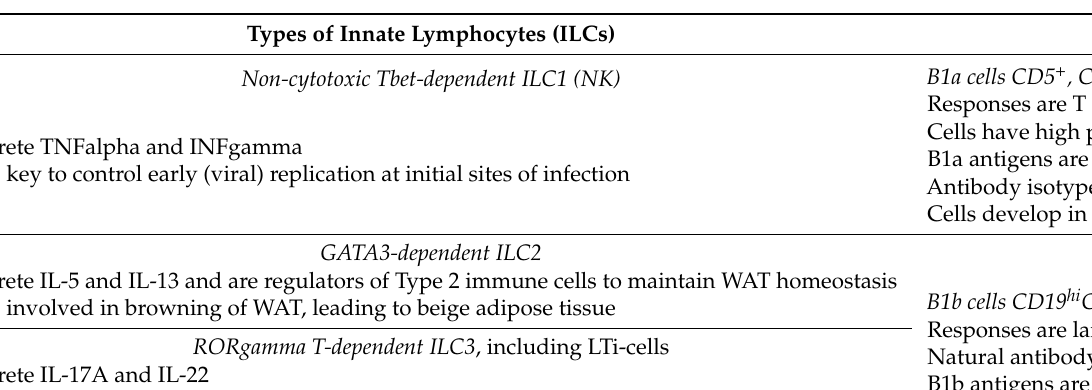
Table 2. Overview of innate lymphocytes in visceral adipose tissue, SALCs/FALCs, and cavities 1